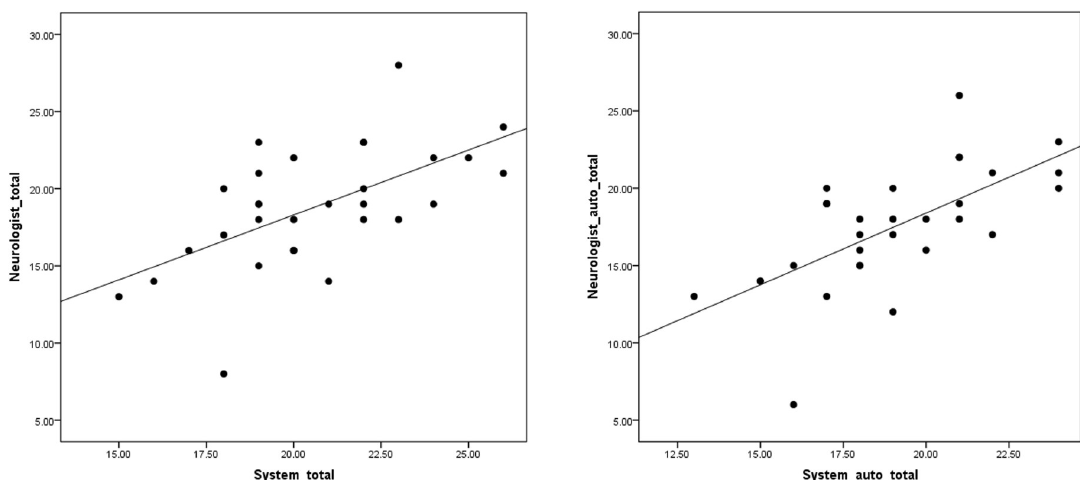
Fig 3. Correlation between a neurologist and the system. Left: Neurologist vs the system (total score), Right: Neurologist vs the system (the automated part without input from the examiner: A1 + A2 + A3 + B + D + E + F).